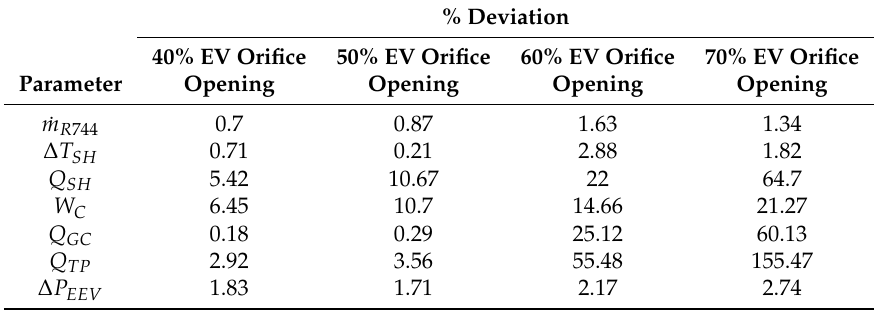
Table 4. Deviation between simulated and test bench results for 40%, 50%, 60%, and 70% EV orifice openings. % Deviation 40% EV Orifice 50% EV Orifice 60% EV Orifice 70% EV Orifice Parameter Opening Opening Opening Opening ˙ m R 744